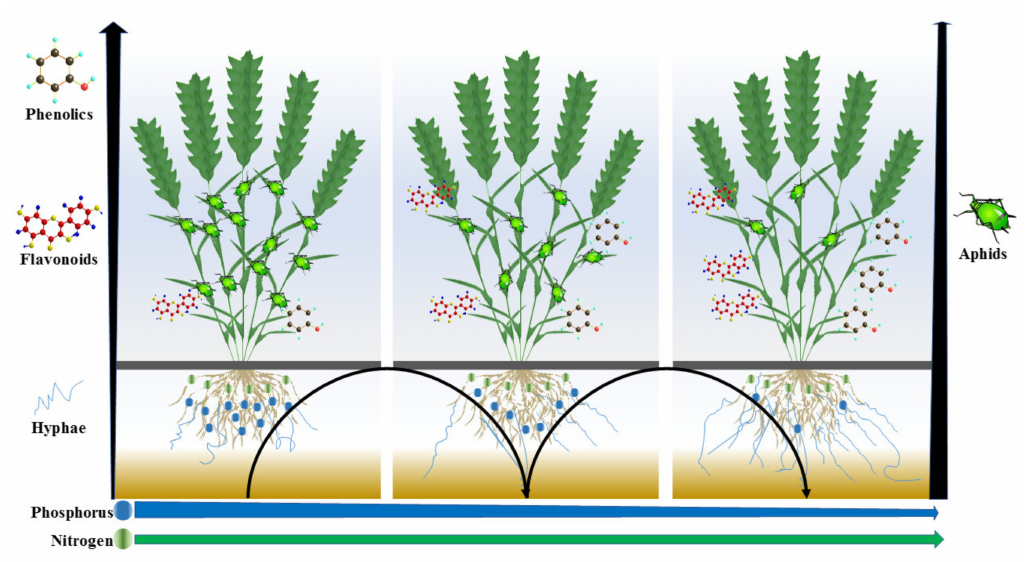
Figure 1. The hypothesis of this study, which claimed that decreasing the phosphorus amount will result in arbuscular mycorrhizal fungi (AMF) colonization of wheat roots. An increase in AMF